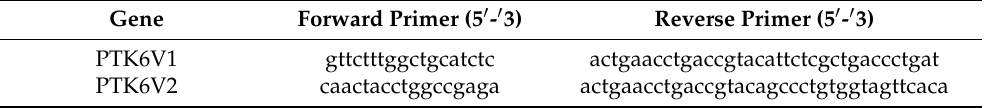
Table 1. Primers used in real-time